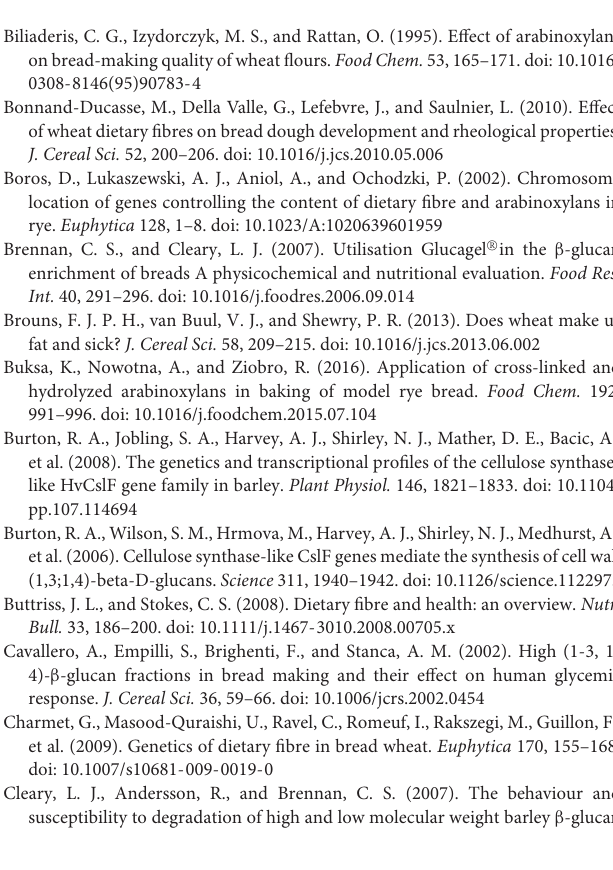
FIGURE S1 | Degradation products obtained after xylanase and lichenase treatment of flour samples and run on HPAEC-PAD [ y -axis: PAD response ( µ V); x -axis: Time (min)]. FIGURE S2 | Thousand kernel weight and compositional properties of mature grains of two lines of bread wheat (cv. Chinese Spring and Mv9kr1 line), two Aegilops species ( Ae. geniculata and Ae. biuncialis ), and wheat– Aegilops chromosome addition lines grown on the field in 2012/2013 season. (a) thousand kernel weight, (b) protein, (c) β -glucan content, (d) TOT-pentosan, (e) WE-pentosan content. LSD, least significant difference; TOT, total; WE, water-extractable. ∗ Significantly higher than the wheat ( T. aestivum )